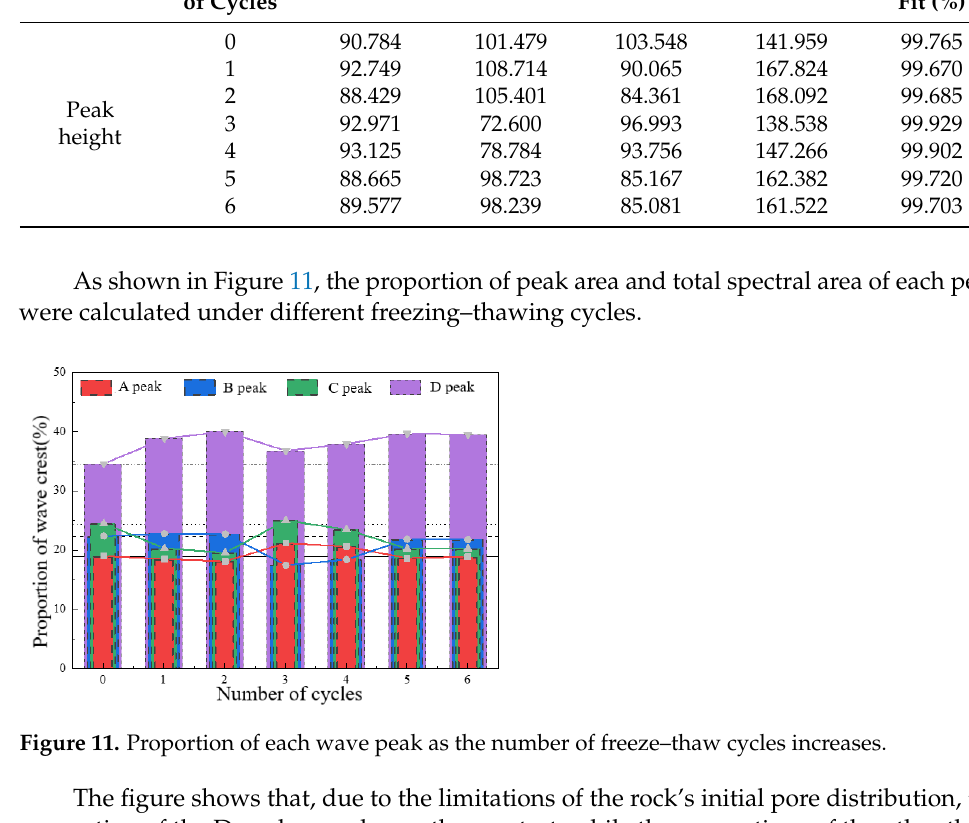
proportion of the D peak was always the greatest, while the proportions of the other three peaks increased and decreased during the freezing–thawing cycles. The test results can be divided into three